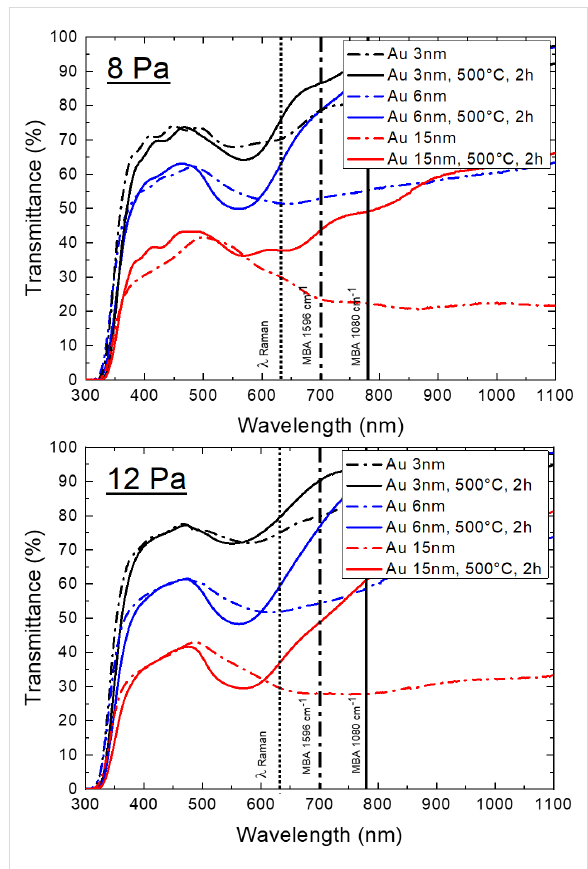
Figure 4: Optical transmission spectra of TiO 2 /Au 8 Pa (a) and 12 Pa (b) samples before and after annealing.